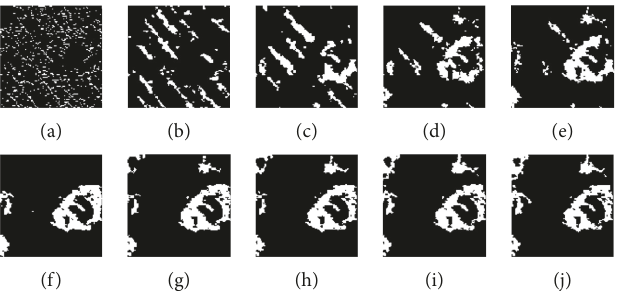
Figure 14: Wood vessels’ peripheral region extraction with different r values. (a) r � 1, (b) r � 6, (c) r � 11, (d) r � 16, (e) r � 21, (f) r � 26,